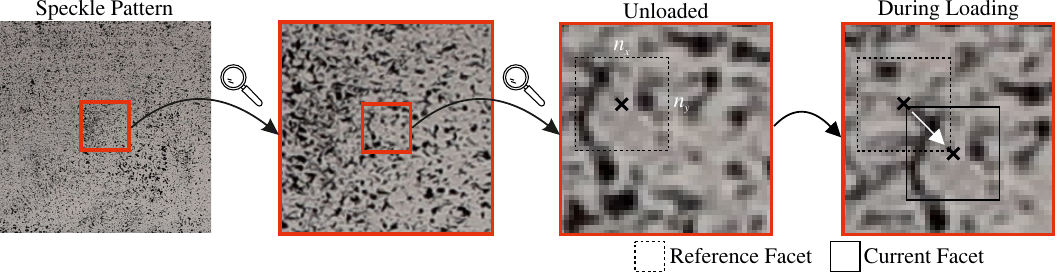
Figure 2. Speckle pattern and schematic representation of facet